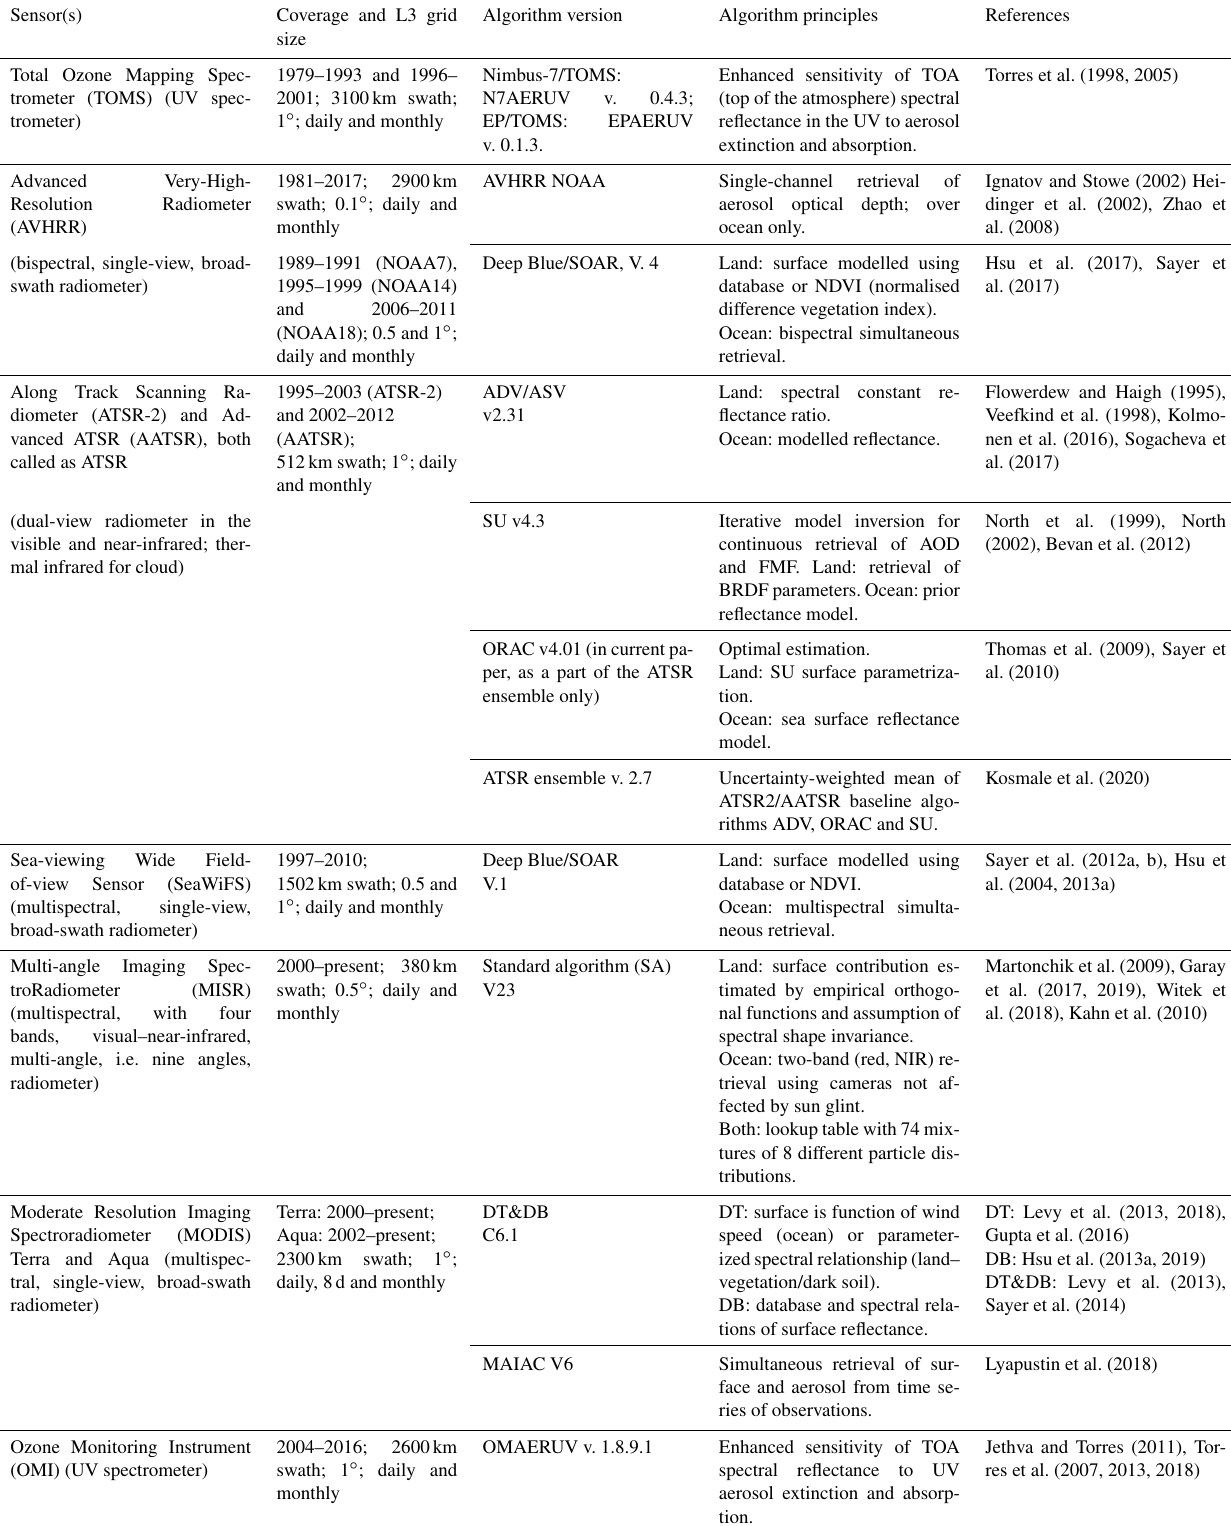
Table 1. Overview of the sensors, data records and AOD algorithms discussed in this paper. For the products availability, see Table